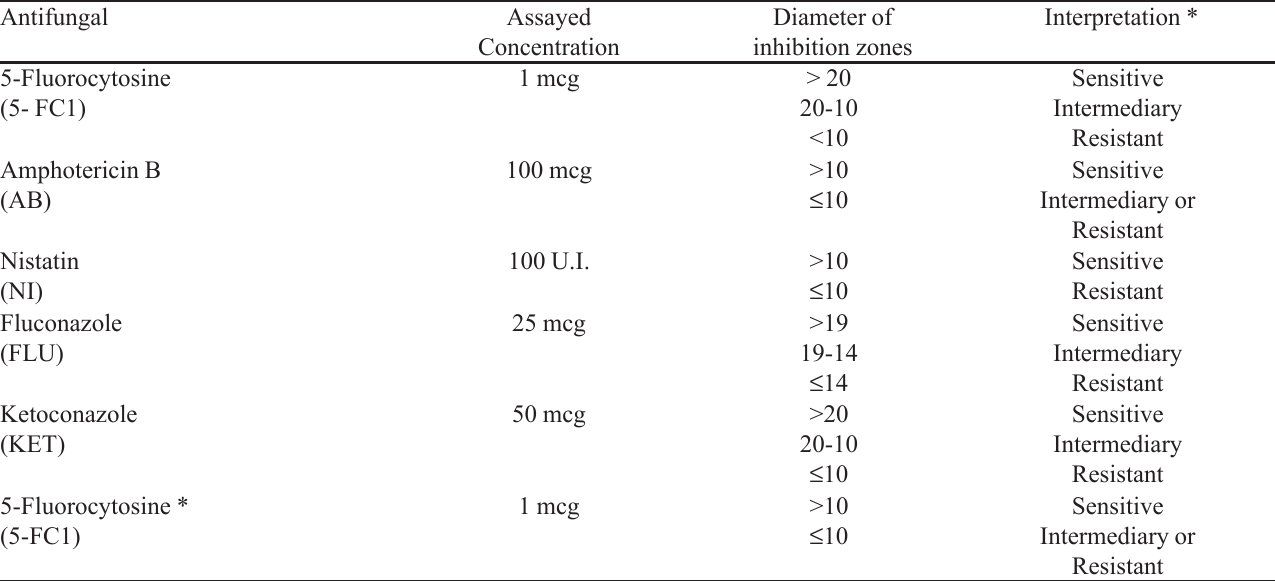
TABLE I - Synthetic compounds applied in the antifungal assays